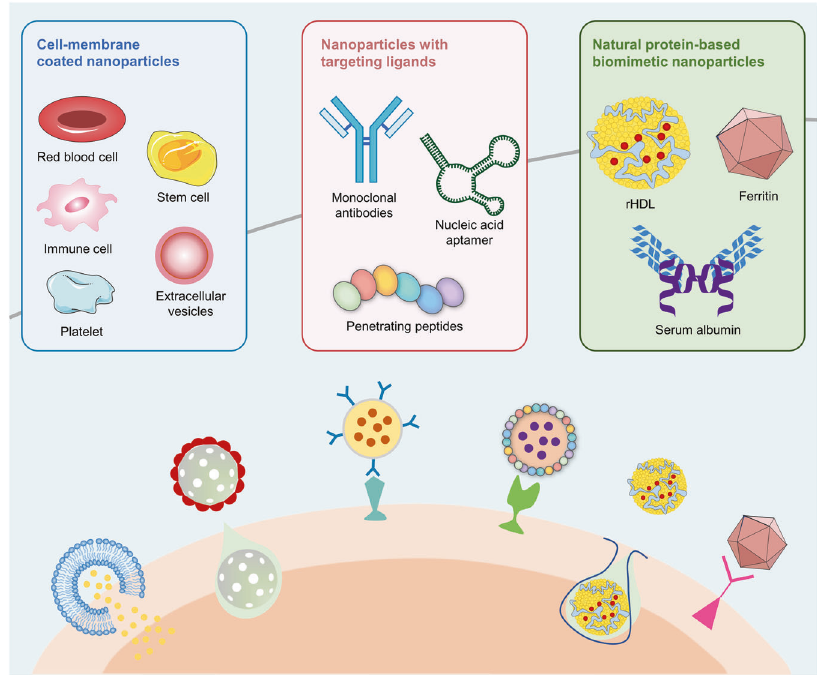
Fig. 3 Schematic illustration of biomimetic nanoparticles. It mainly includes cell-membrane-coated nanoparticles, nanoparticles with targeting ligands, and natural protein-based biomimetic nanoparticles. rHDL reconstituted high-density